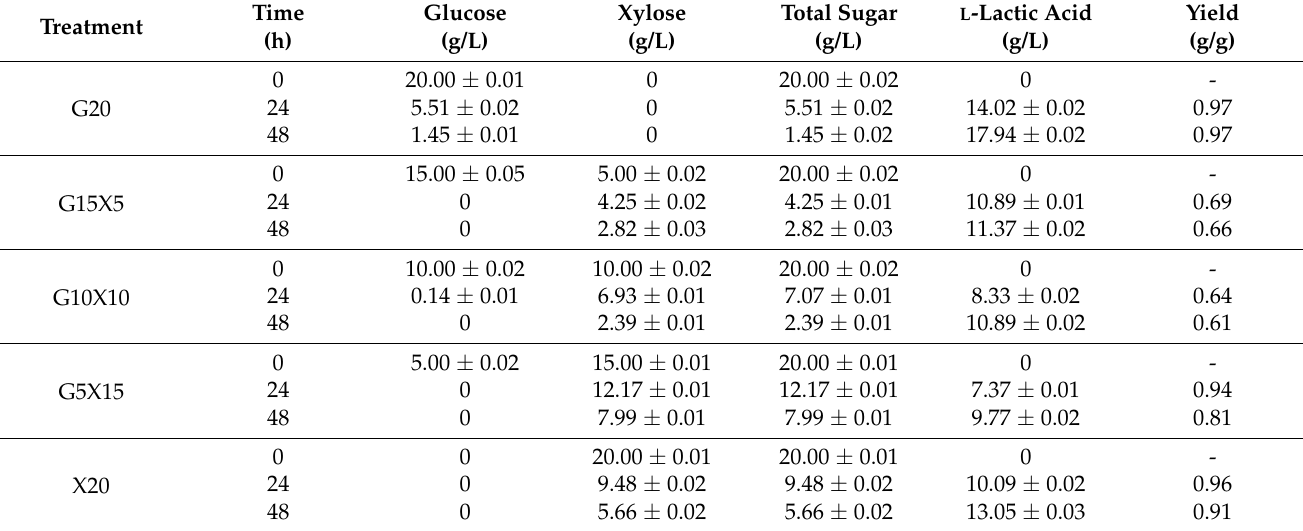
Table 2. The remaining glucose and xylose and L -lactic acid produced by E. mundtii WX1 using various glucose-xylose mixtures in MRS broth under static incubation at 37 ◦ C for 48 h.